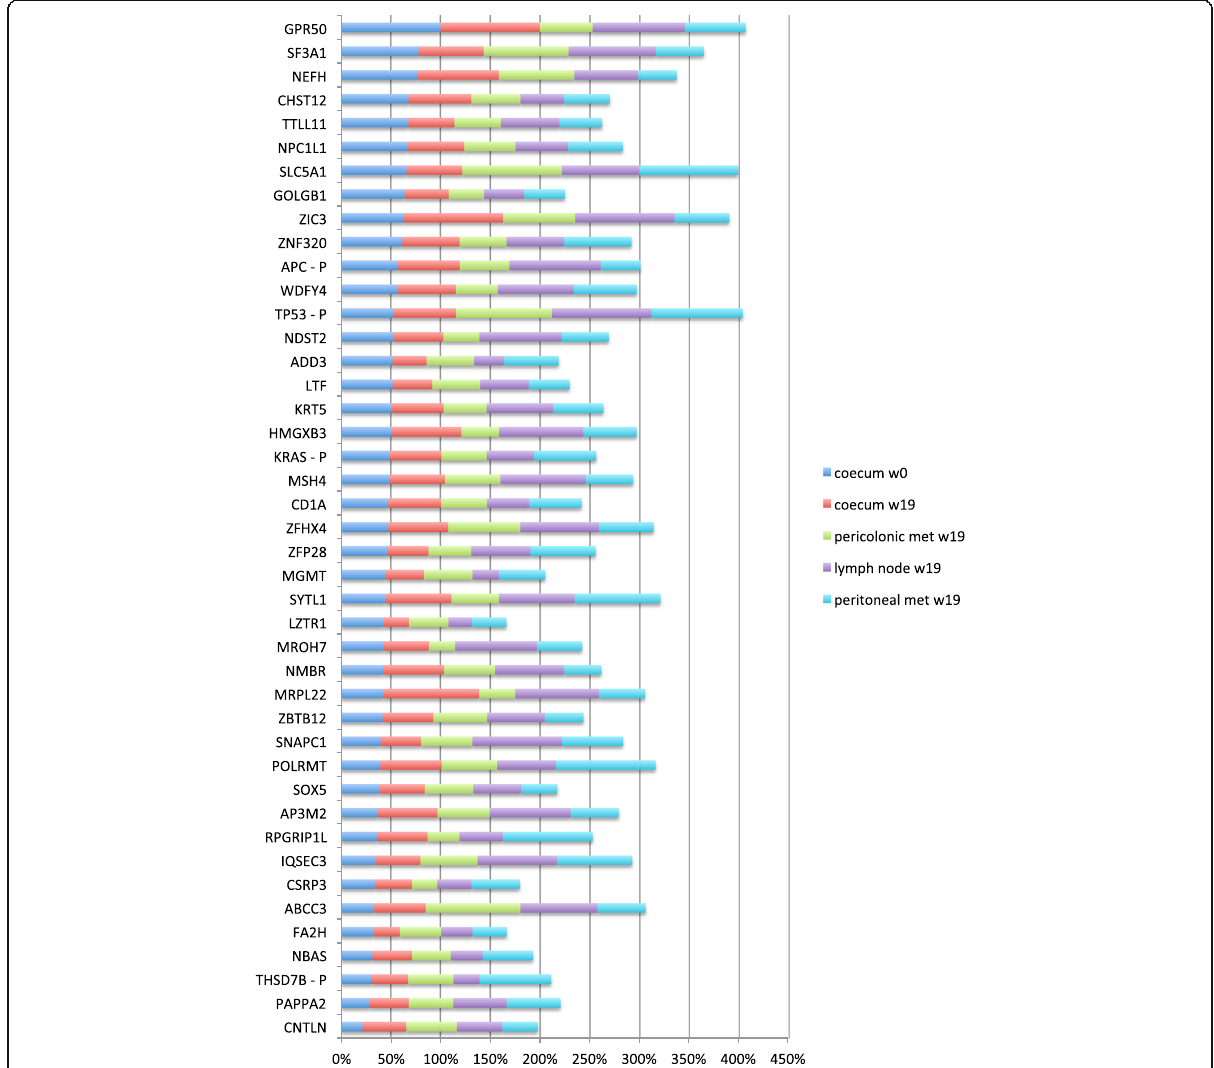
Fig. 2 Horizontal stacked bar chart showing normalized somatic mutation allele frequencies detected in tumour tissue samples by whole exome sequencing. The mutation with highest tumour allele frequency in a sample is scaled to 100% and the remaining mutations are scaled accordingly. The chart compares the most prominent tumour mutations between samples, irrespective of the tumour cell content in a tissue sample. P marks genes that were covered in plasma cfDNA pan-cancer